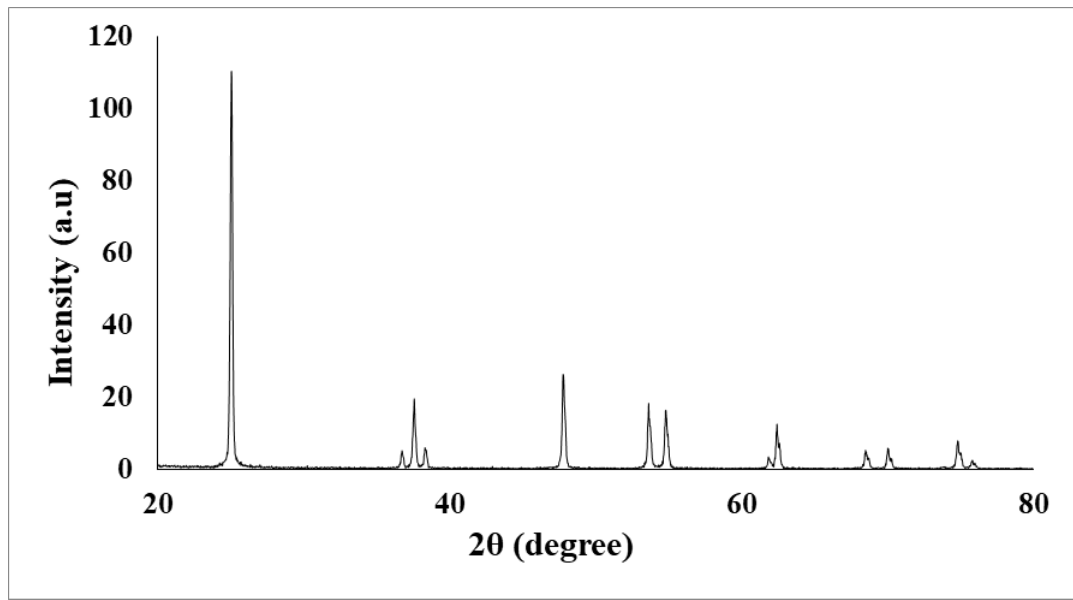
Figure 5. Results of the X-ray diffraction (XRD) analysis.